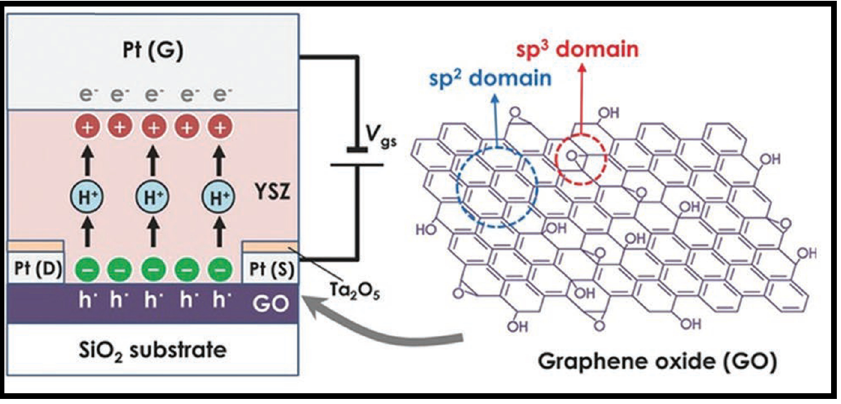
Figure 8: Schematic illustration of GO - based all - solid - state electric double - layer transistor. G, S, and D denote the gate, source, and drain electrodes [ 92 ] .